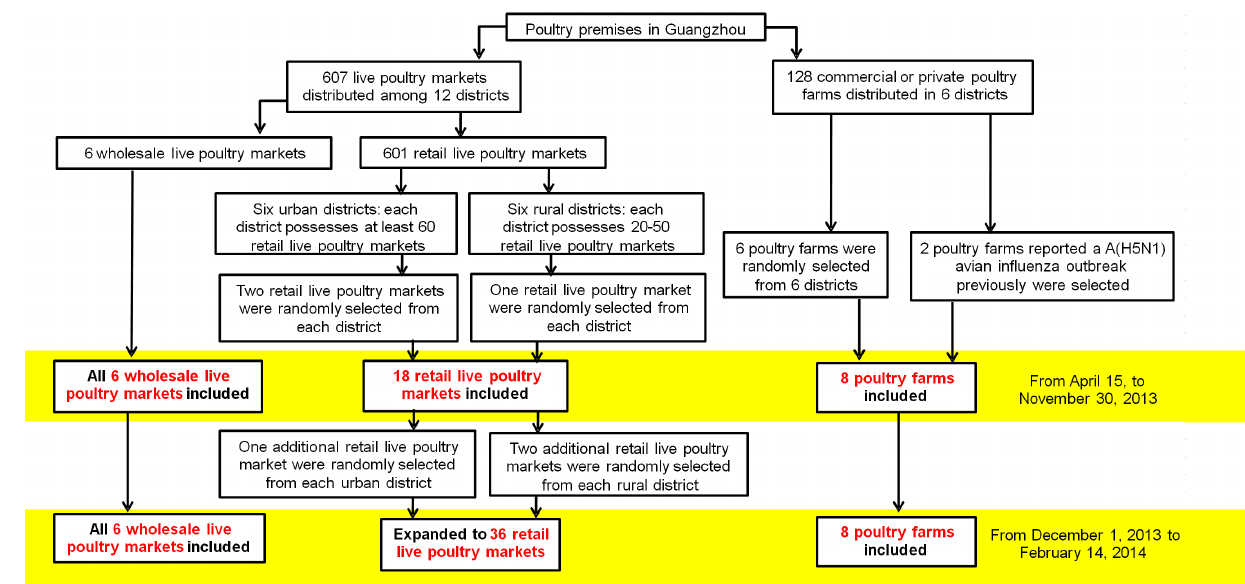
Figure 1. Enrollment of surveillance sites of the virologic surveillance program for A(H7N9) in Guangzhou, China.